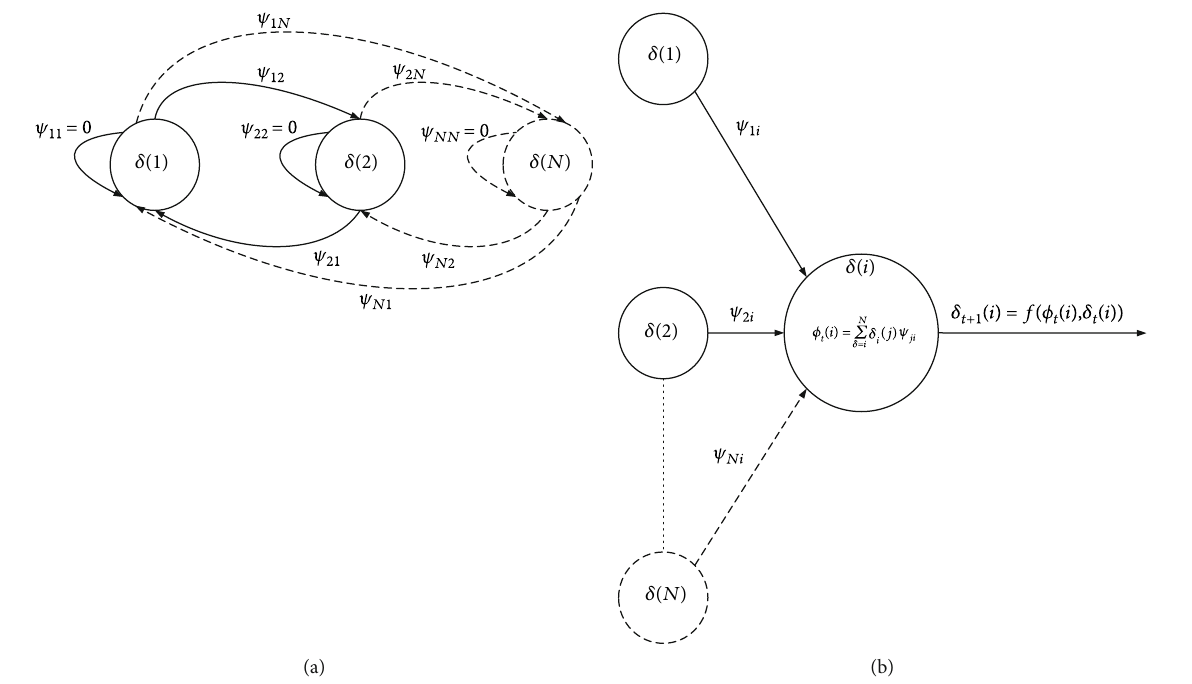
Figure 2: (a) HNN and (b) propagation rule and activation function.